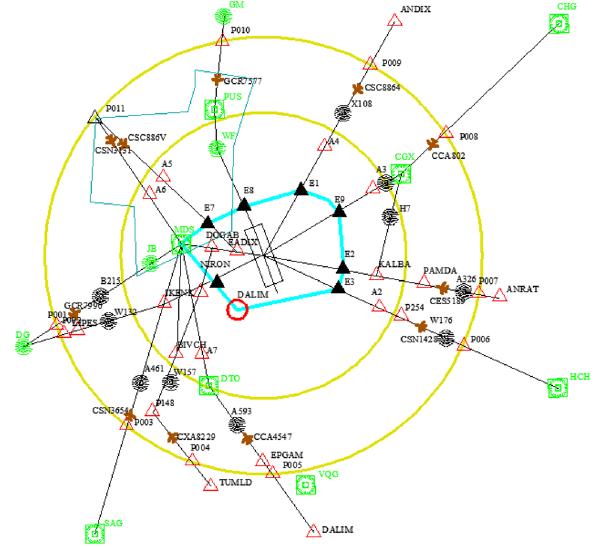
Fig. 1 The spatiotemporal model of airport terminal